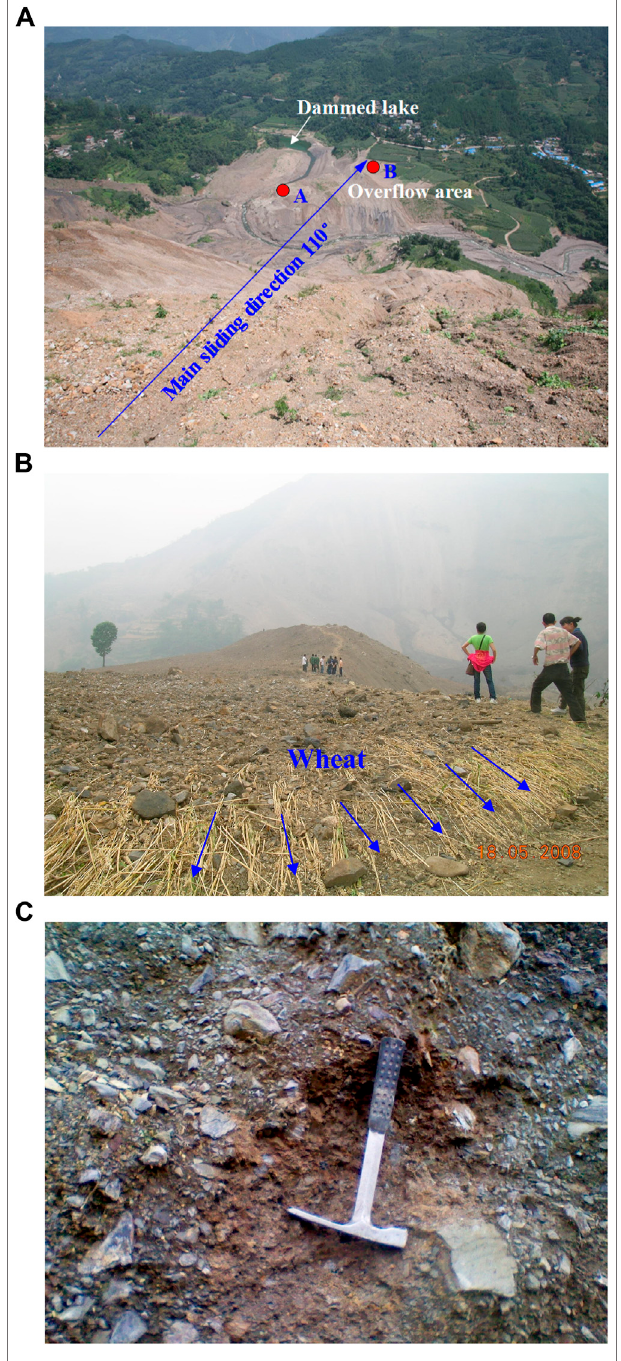
FIGURE 6 | Deposition area of the Taihongcun landslide. (A) Granular debris covered the Duba rive and the farmlands (the landslide dam had already been breached arti fi cially). (B) Air wave blew down the wheat due to granular debris on the location shown as the red circle B in Figure 6A . (C) Compact landslide deposits composed of angular fragments on the location shown as the red circle A in Figure 6A